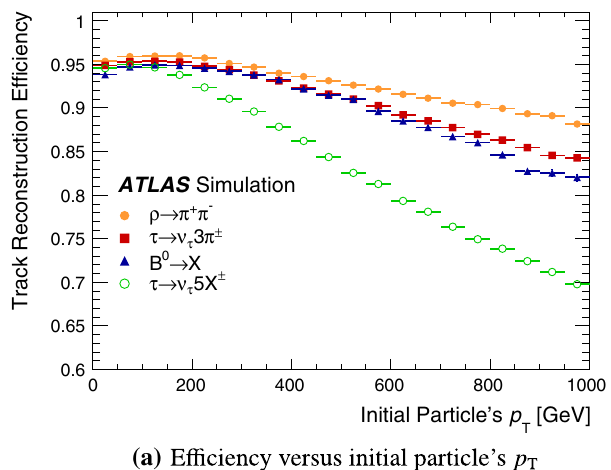
Fig. 12 Single-track reconstruction efficiency is shown as a a function of the initial particle’s p T when it is required that the parent particle decays before the IBL for the decay products of a ρ , three- and five-